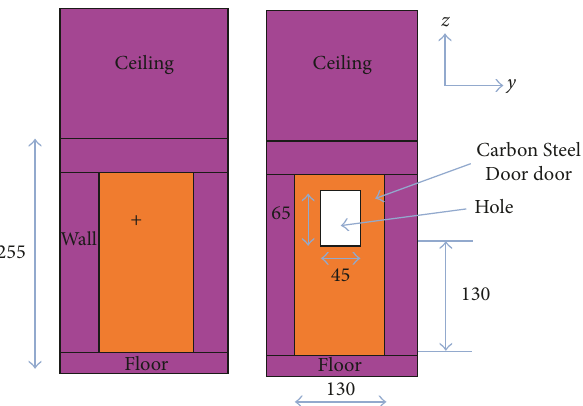
Figure 3: MCNPX model 𝑌𝑍 view of the door with and without hole in the labyrinth entrance of the CDTN Gamma Irradiation Laboratory. All dimensions are given in cm.